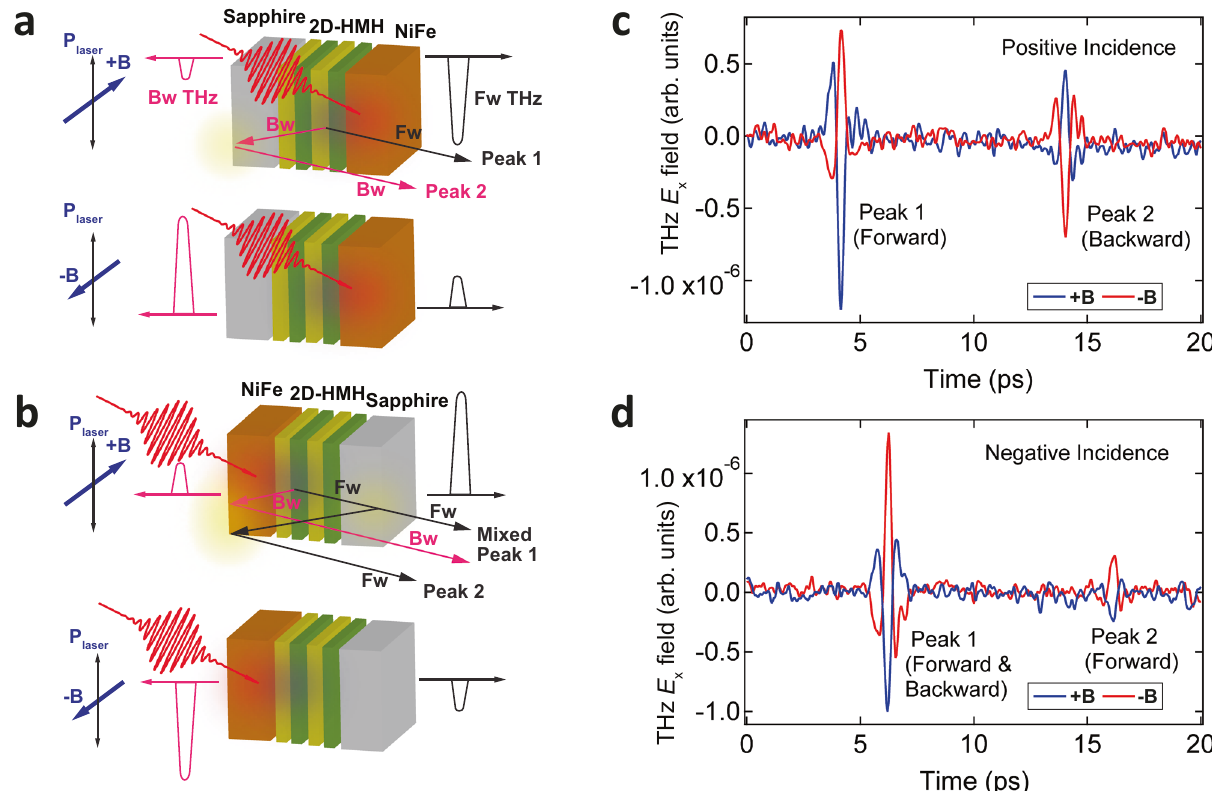
Fig. 3 Sample orientation dependence of asymmetric THz radiation. a , b Schematic illustration of the E x component of generated THz electric fi eld in 2D- HMH/NiFe heterostructure using front and back pump con fi gurations, respectively. The red and blue spots illustrate where the laser pulse is absorbed in the NiFe layer and THz emission is emitted from the 2D-HMH layer, respectively. The black (pink) solid lines represent the optical paths of the forward (backward) THz emission inside the device. The yellow spots indicate the positions where the THz emissions are re fl ected. c, d Obtained electric fi eld of THz radiation along the x -direction as a function of time for opposite incidence direction of light, showing a clear sample orientation dependence of the directionality of the E x component: The directionality and phase of the E x component of THz radiation change their polarity with the magnetization and sample fl ips,